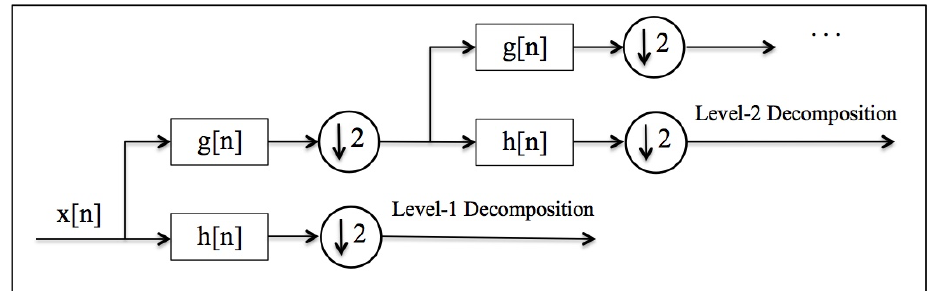
Figure 3. Wavelet decomposition of a signal x [ n ]